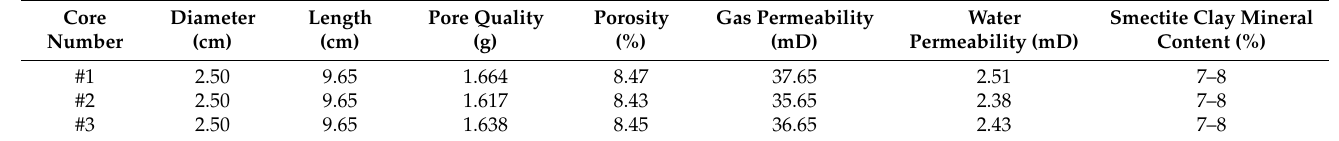
Table 1. The properties of the synthetic